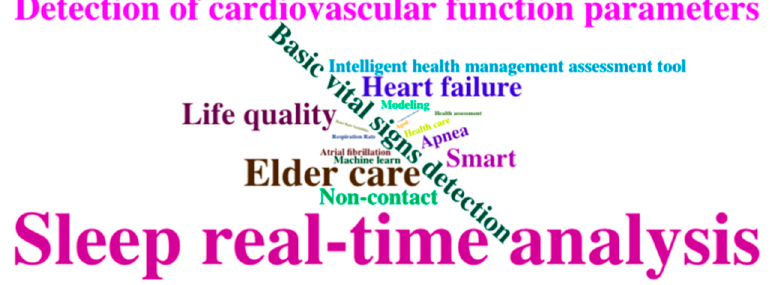
Figure 4. Hot keywords in the literature.